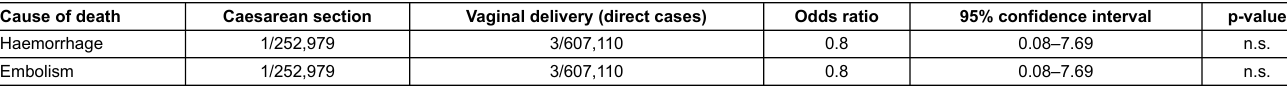
Table 6: Cause of death in relation to caesarean section (vaginal deliveries = 67.9% of 787,007 live births). Cause of